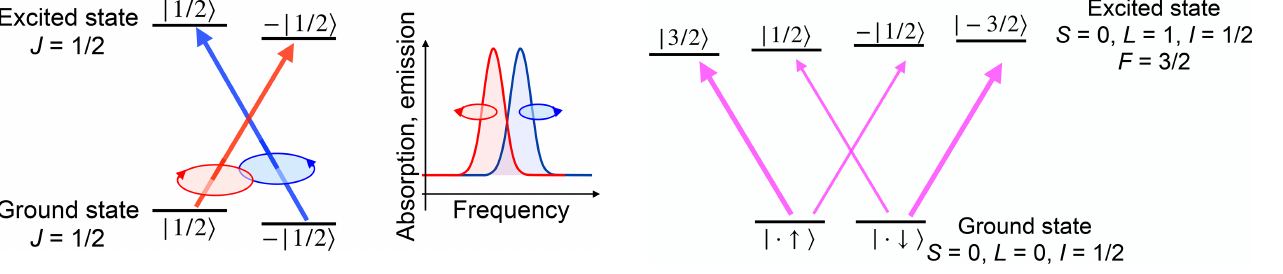
Figure 12. Detection of a nuclear spin state in a system with van- ishing electron spin in the ground state. The transition strength of √ the thinner arrows is 3 / 3 ≈ 0 . 58 times that of the thicker